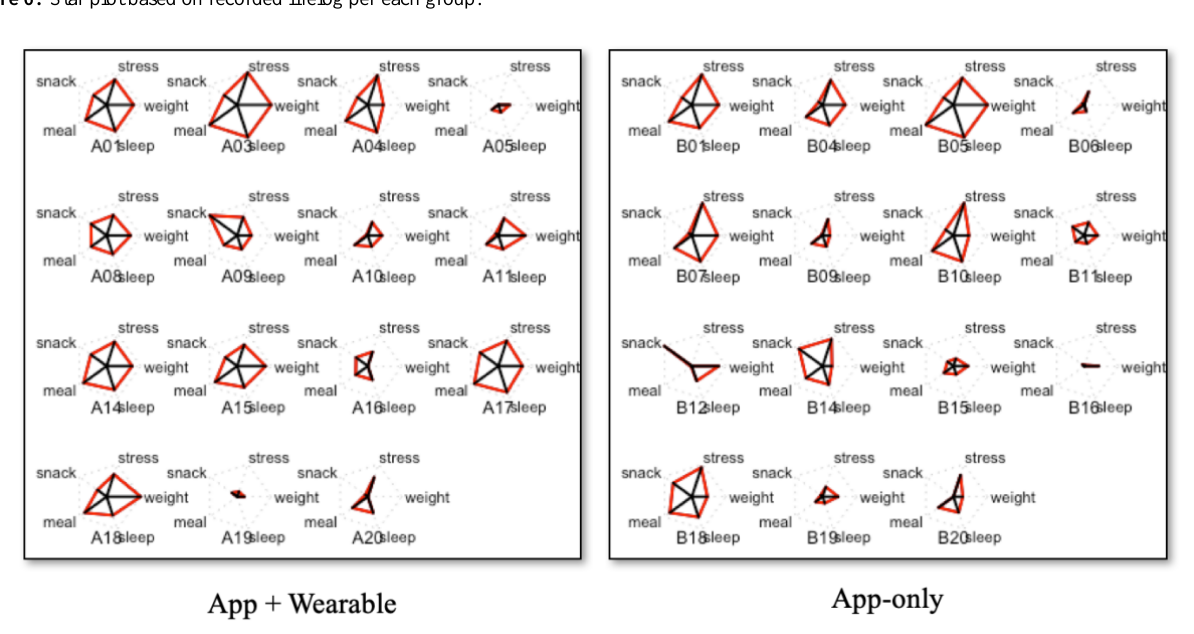
MaximumThird quartileMeanMedianFirst quartileMinimumIndices